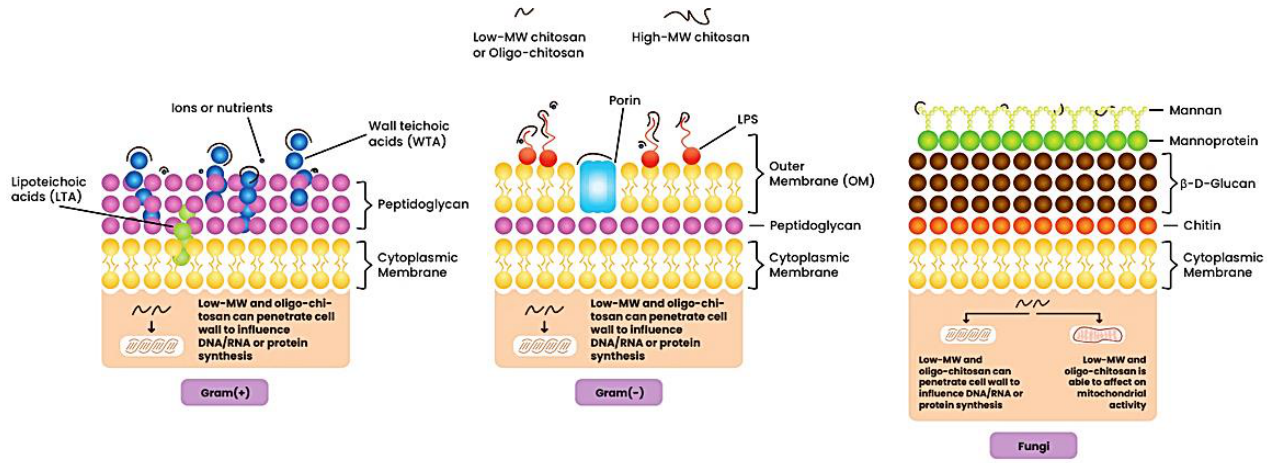
Figure 1. Schematic of action modes of chitosan on Gram-positive bacteria, Gram-negative bacteria, and fungi. Inspired by [18].